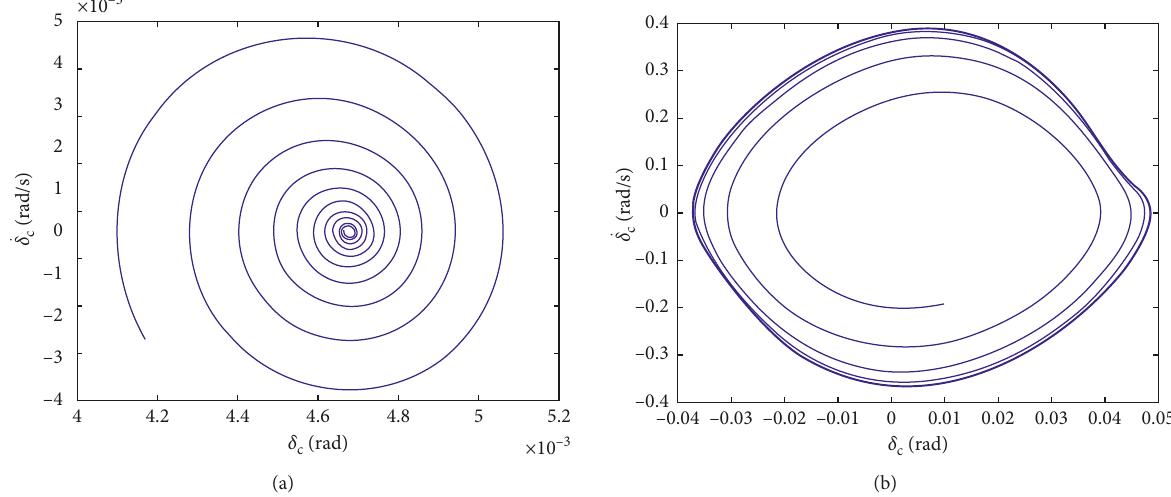
Figure 6: Phase diagram of compliance steering angle: (a) u